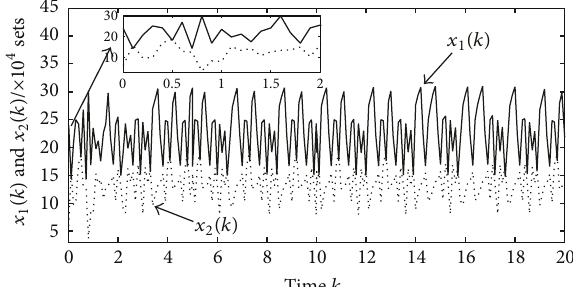
Figure 3: Evolution processes of inventory levels under the robust 𝐻 ∞ control strategy.